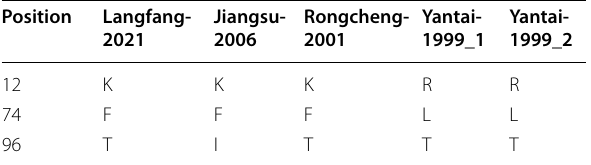
Table 2 Consensus amino acids at 3 positions in the Chinese wheat mosaic virus coat protein amino acid sequence alignment for different CWMV